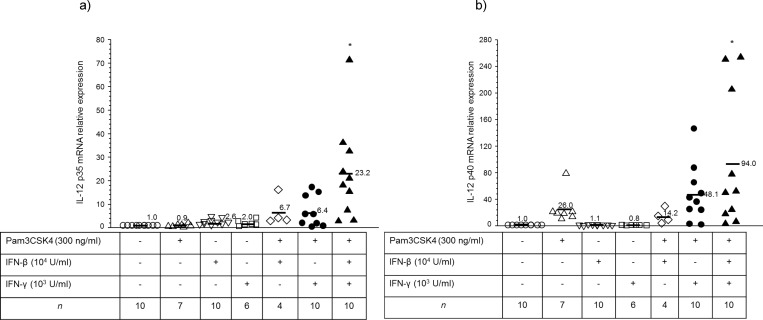
Optimization of interleukin (IL)-12 p35 and p40 mRNA expression in human neonatal monocyte-derived dendritic cells (mdDCs).Neonatal mdDCs were primed with recombinant (r) interferon-β (IFN-β) (Type I IFN), and rIFN-γ (Type II IFN) for 12 hours prior to stimulating them with a synthetic TLR2 agonist, Pam3CSK4. The combination of Pam3CSK4, rIFN-β, and rIFN-γ induced the maximal levels of (a) interleukin (IL)-12 p35 mRNA and (b) IL-12 p40 mRNA expression in human neonatal monocyte-derived dendritic cells (mdDCs). * p<0.05 compared to unstimulated control. Data points represent individual donors, the number of individual donors for each condition is shown in the figure, and bars are mean values.